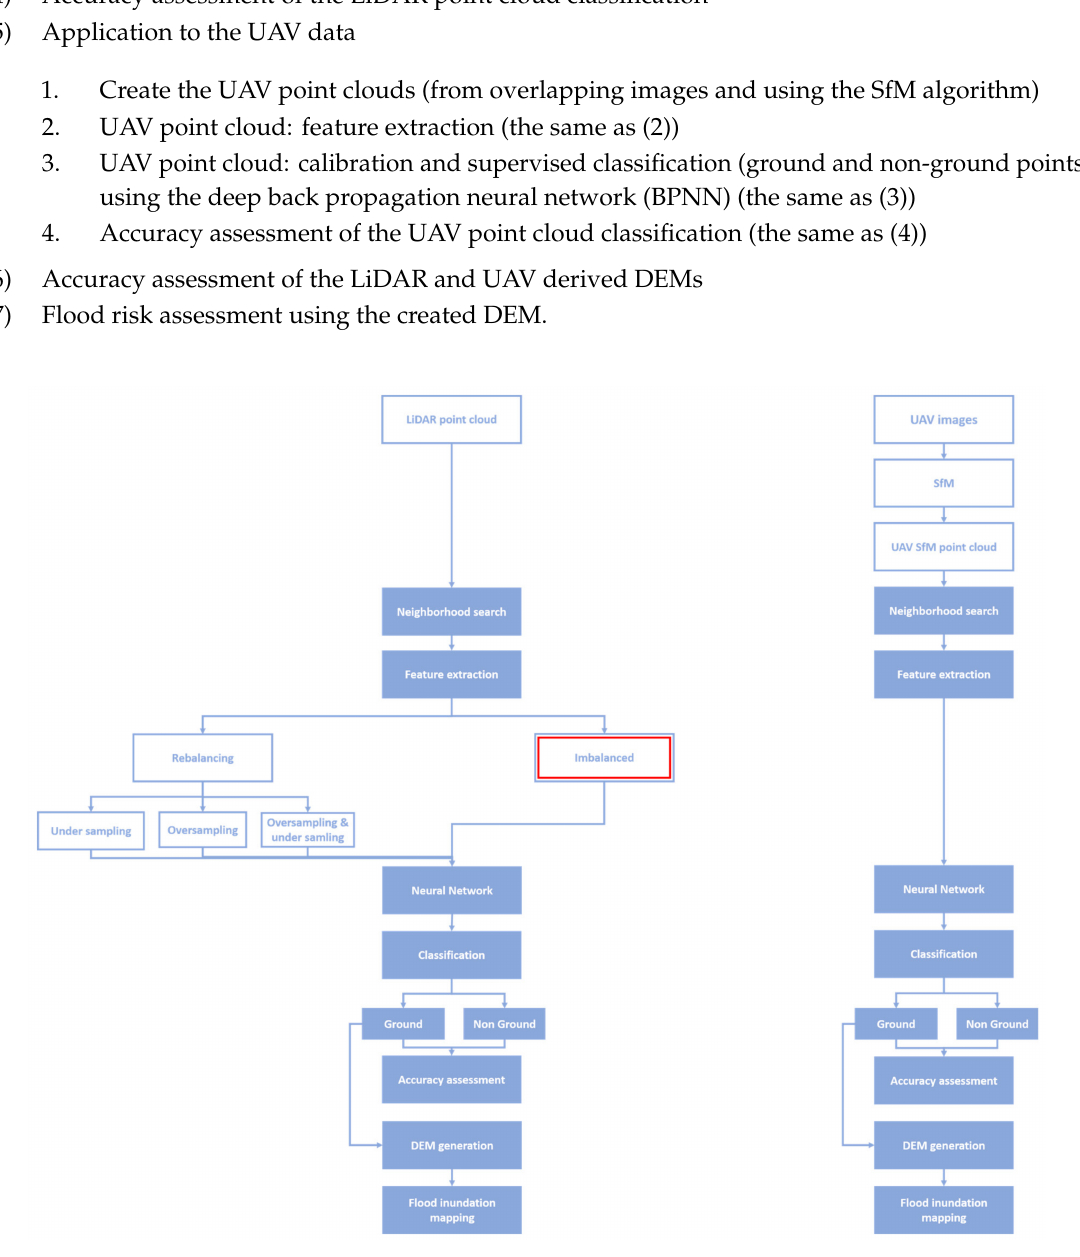
Figure 2. Workflow. Note: the same steps for light detection and ranging (LiDAR) and unmanned aerial vehicle (UAV) data are shaded with dark blue color. SfM, structure from motion, DEM, digital elevation